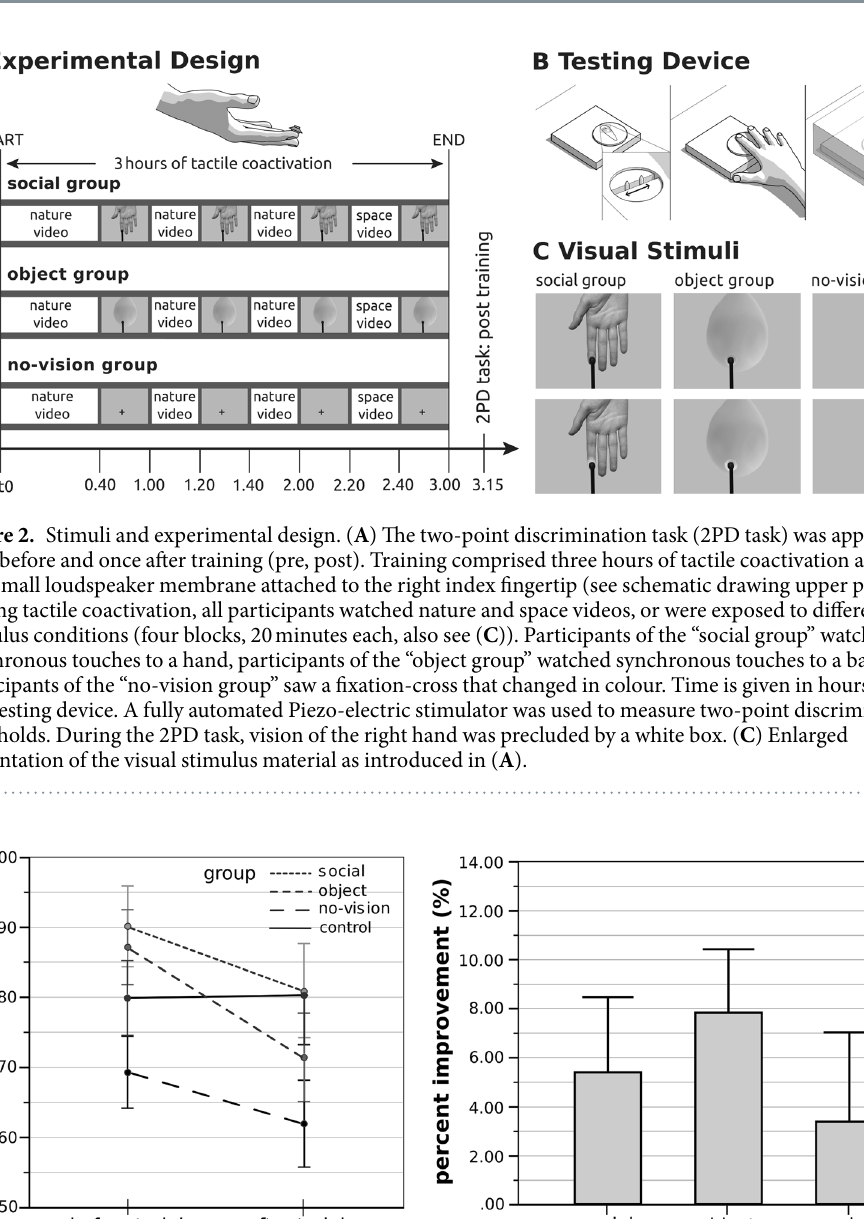
no-vision group: 1.65 ± 0.23 mm), but no interaction between group and training ( F (2,45) = 0.63, p = 0.54, ƞ ² = 0.03). The main effect of training (pre vs post) was due to a significantly lower two-point discrimination threshold at the tip of the right index finger after the tip of the right index finger had been coactivated for three hours compared to before the training across groups (two-point discrimination threshold pre = 1.82 ± 0.25 mm, post = 1.71 ± 0.28 mm, difference pre – post = 0.11 ± 0.22 mm; see Fig. 2 for design and stimuli). We also inves- tigated the effect of group on training by conducting a one-way ANOVA with the factor group (social, object, no-vision) with training effect (in %) as dependent variable. There was no main effect of group ( F (2,45) = 0.51, p = 0.60, see Fig. 3). We also conducted ANOVAs taking the two-point discrimination thresholds at the 25% and 75% levels (rather than the 50% level, see above) as well as response variability (steepness of the curve = difference 75% threshold